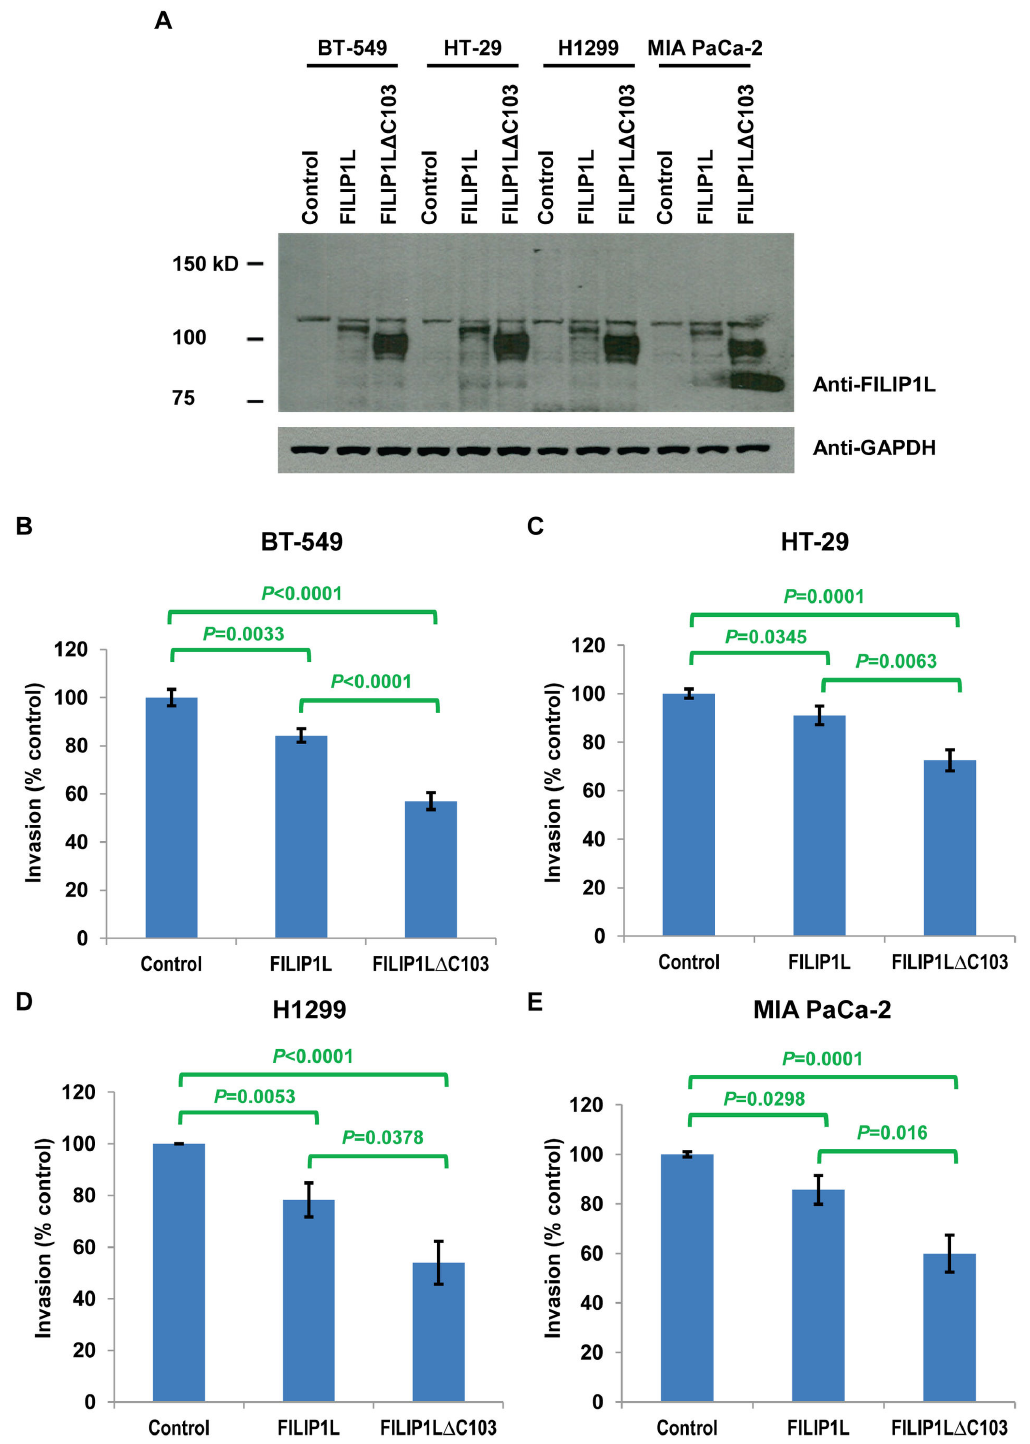
Figure 7. Inhibition of cell invasion following FILIP1L expression in various FILIP1L-low-expressing, highly-invasive cancer cell lines. The same cell lines used in Figure 4 were transfected with control, wild-type FILIP1L or FILIP1LΔC103 cDNA. A , Immunoblot analysis for FILIP1L in the transfected cells. GAPDH blot is shown as the loading control. B - E , Transfected cells were subject to Matrigel cell invasion assay 24 h after transfection. The same experimental procedures were followed as described in Figure 6. The result is representative of two independent experiments. doi: 10.1371/journal.pone.0082620.g007 PLOS ONE |